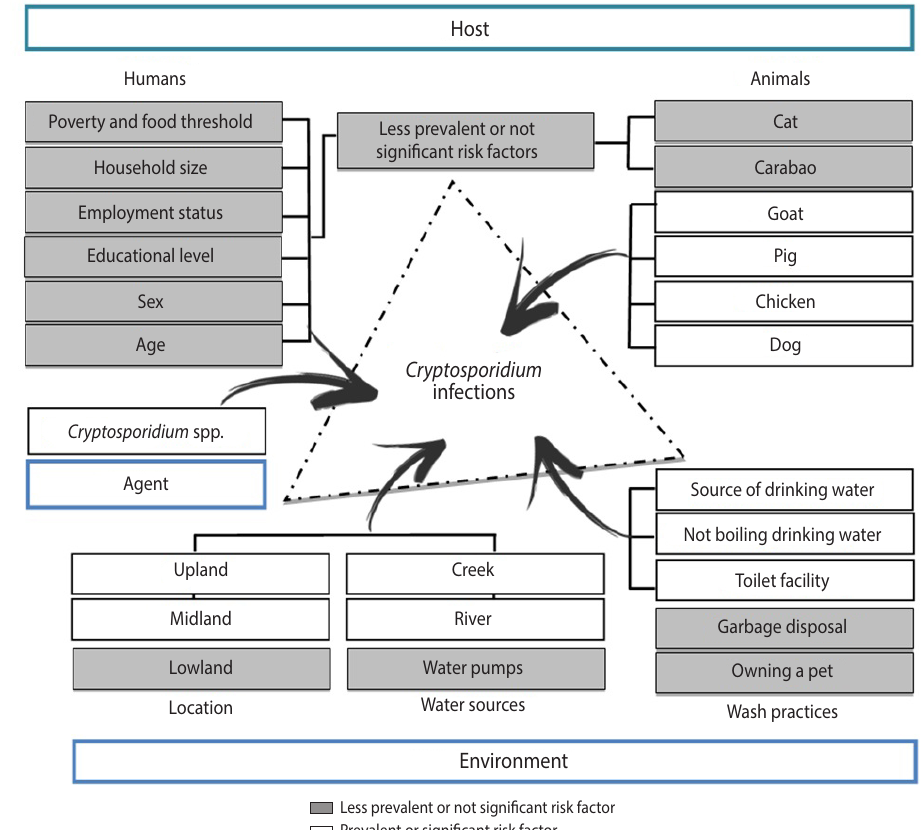
Figure 3. Epidemiologic triad of Cryptosporidium infection